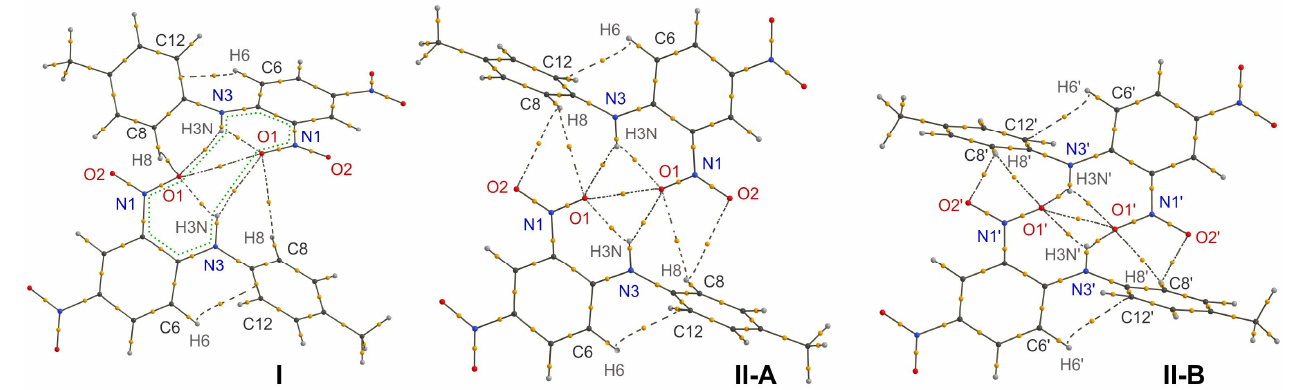
Figure 2. Topological graphs of the H-bonded dimers in polymorphs I and II (two crystallographically independent molecules A and B ). Bond critical points are drawn as orange spheres, bond paths for non-covalent interactions are drawn with dashed lines. The intermolecular R 2 2 (12) H-bonded graph set is shown with a green dotted line using form I as an